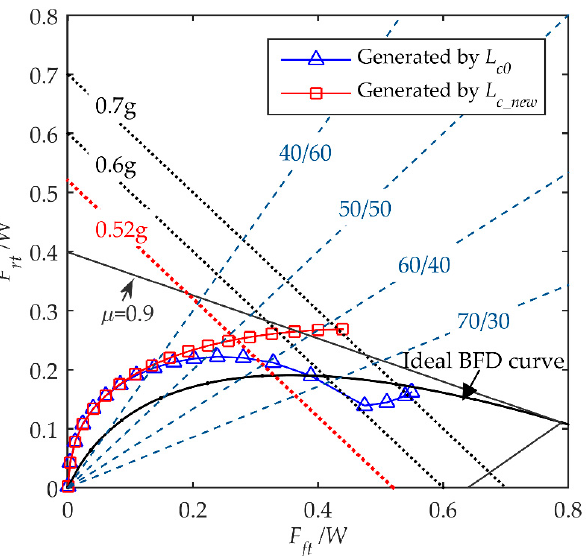
Figure 7. Comparison of the braking force distribution (BFD) curve using the original cam profile with that using the newly designed cam profile.